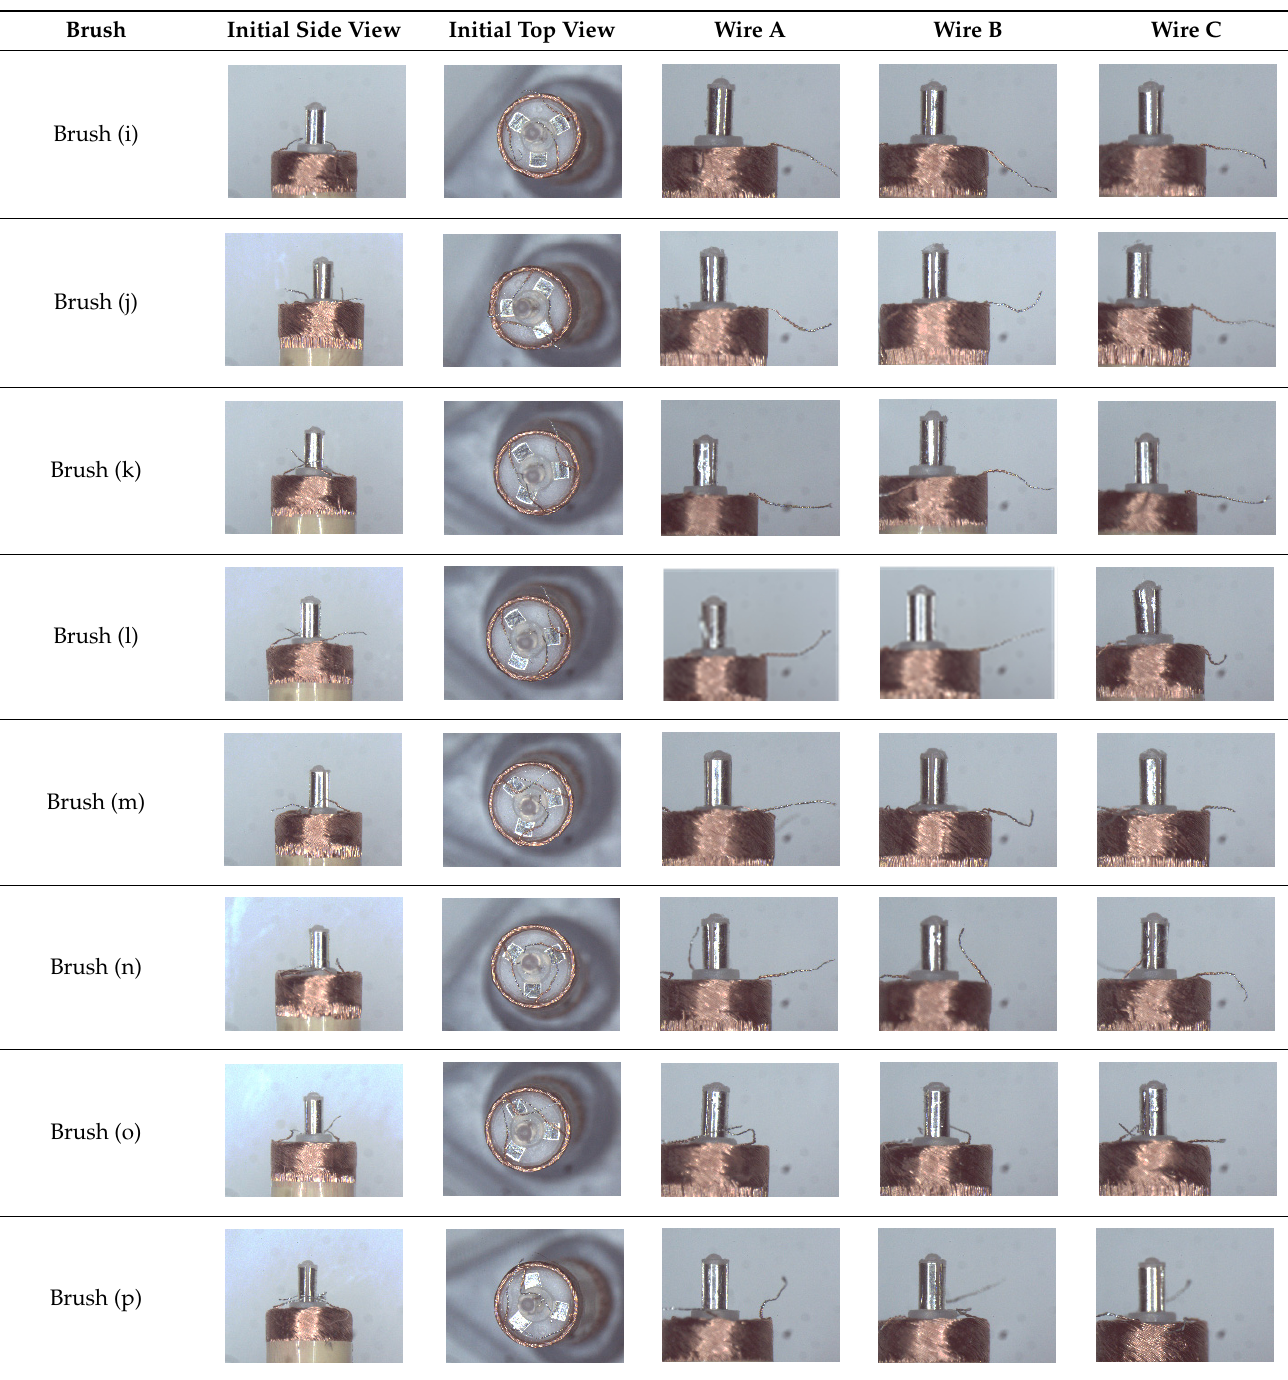
Table 8. Subjective evaluation of brushing results for sixteen horizontal micro-manipulators. Brush